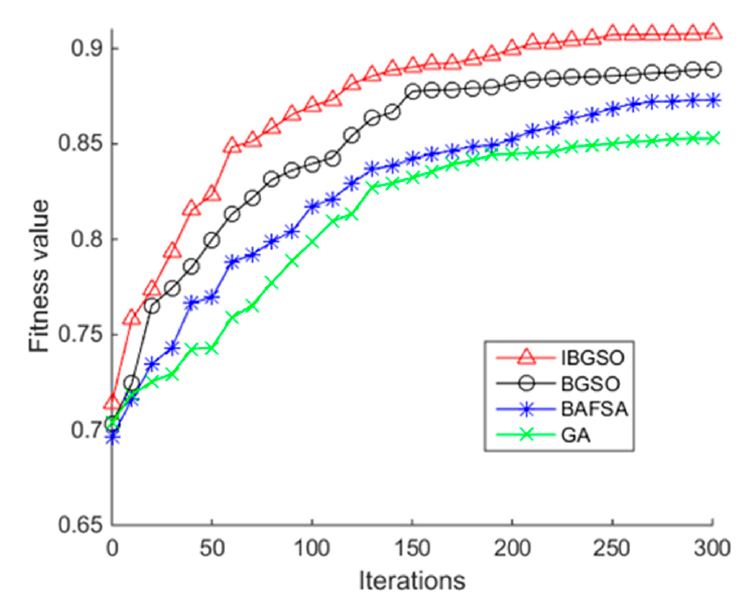
Figure 7. Relationship between the fitness value of the heuristic algorithms and iterations using the DSA.